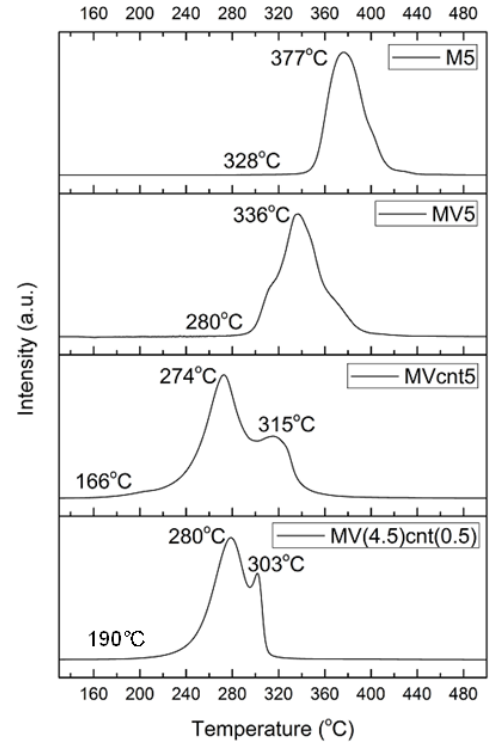
Figure 8. TPD-MS profiles of M5, MV5, MVcnt5 and